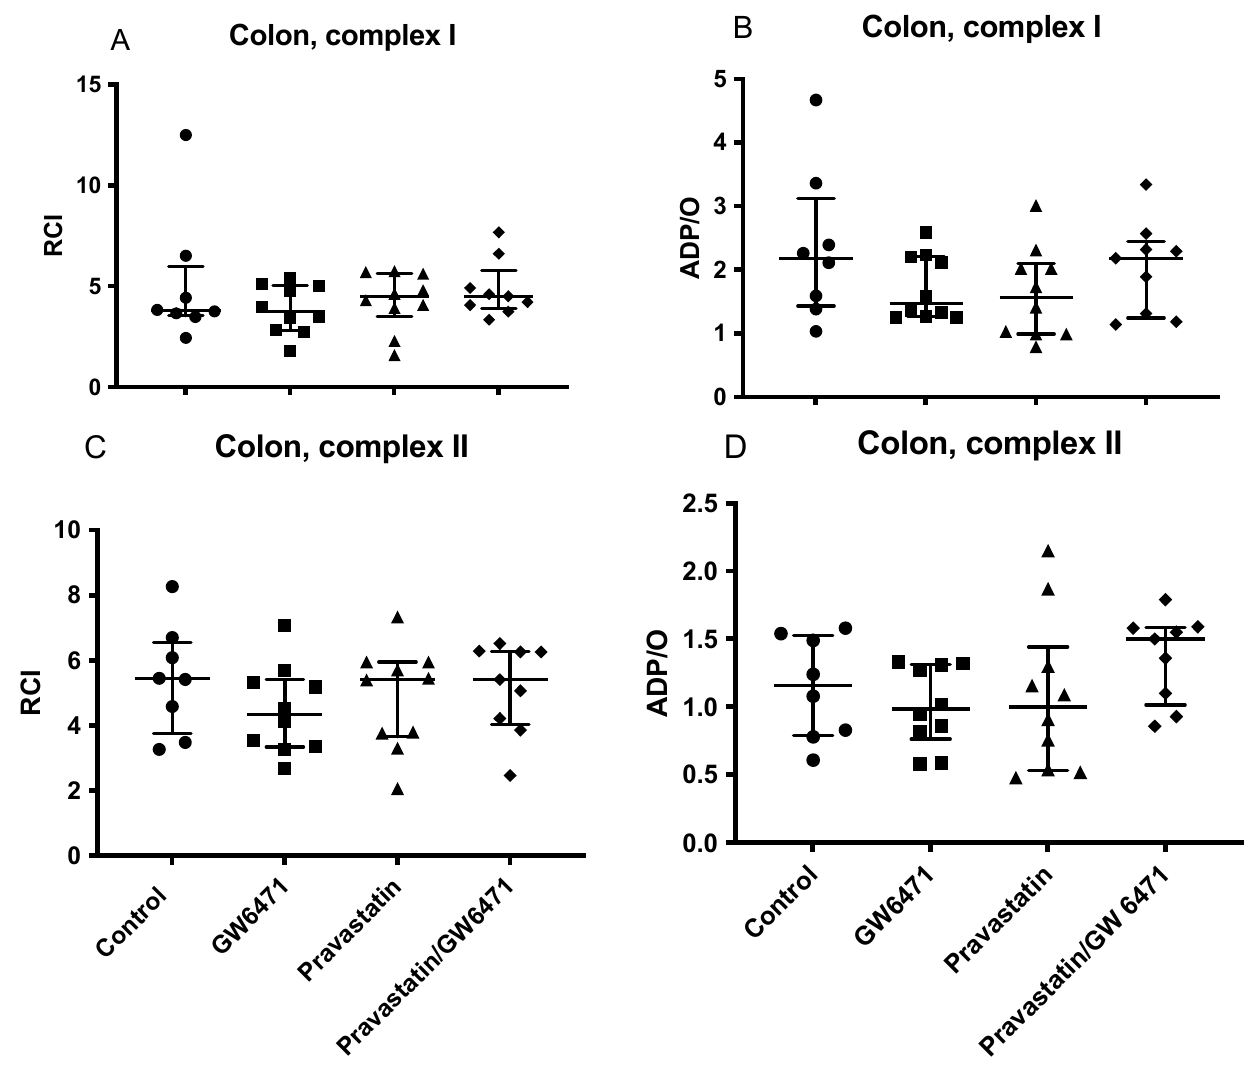
Figure 3. Effect of pravastatin, GW6471, and the combination of both on colonic mitochondrial respiration: RCI (state 3/state 2) ( A , C ), (ADP/O = ADP added/oxygen consumed in state 3) ( B , D ). All mitochondrial parameters were analysed for complex I ( A , B ) and II ( C , D ). Data are presented as individual values, median with interquartile range n = 8–10.